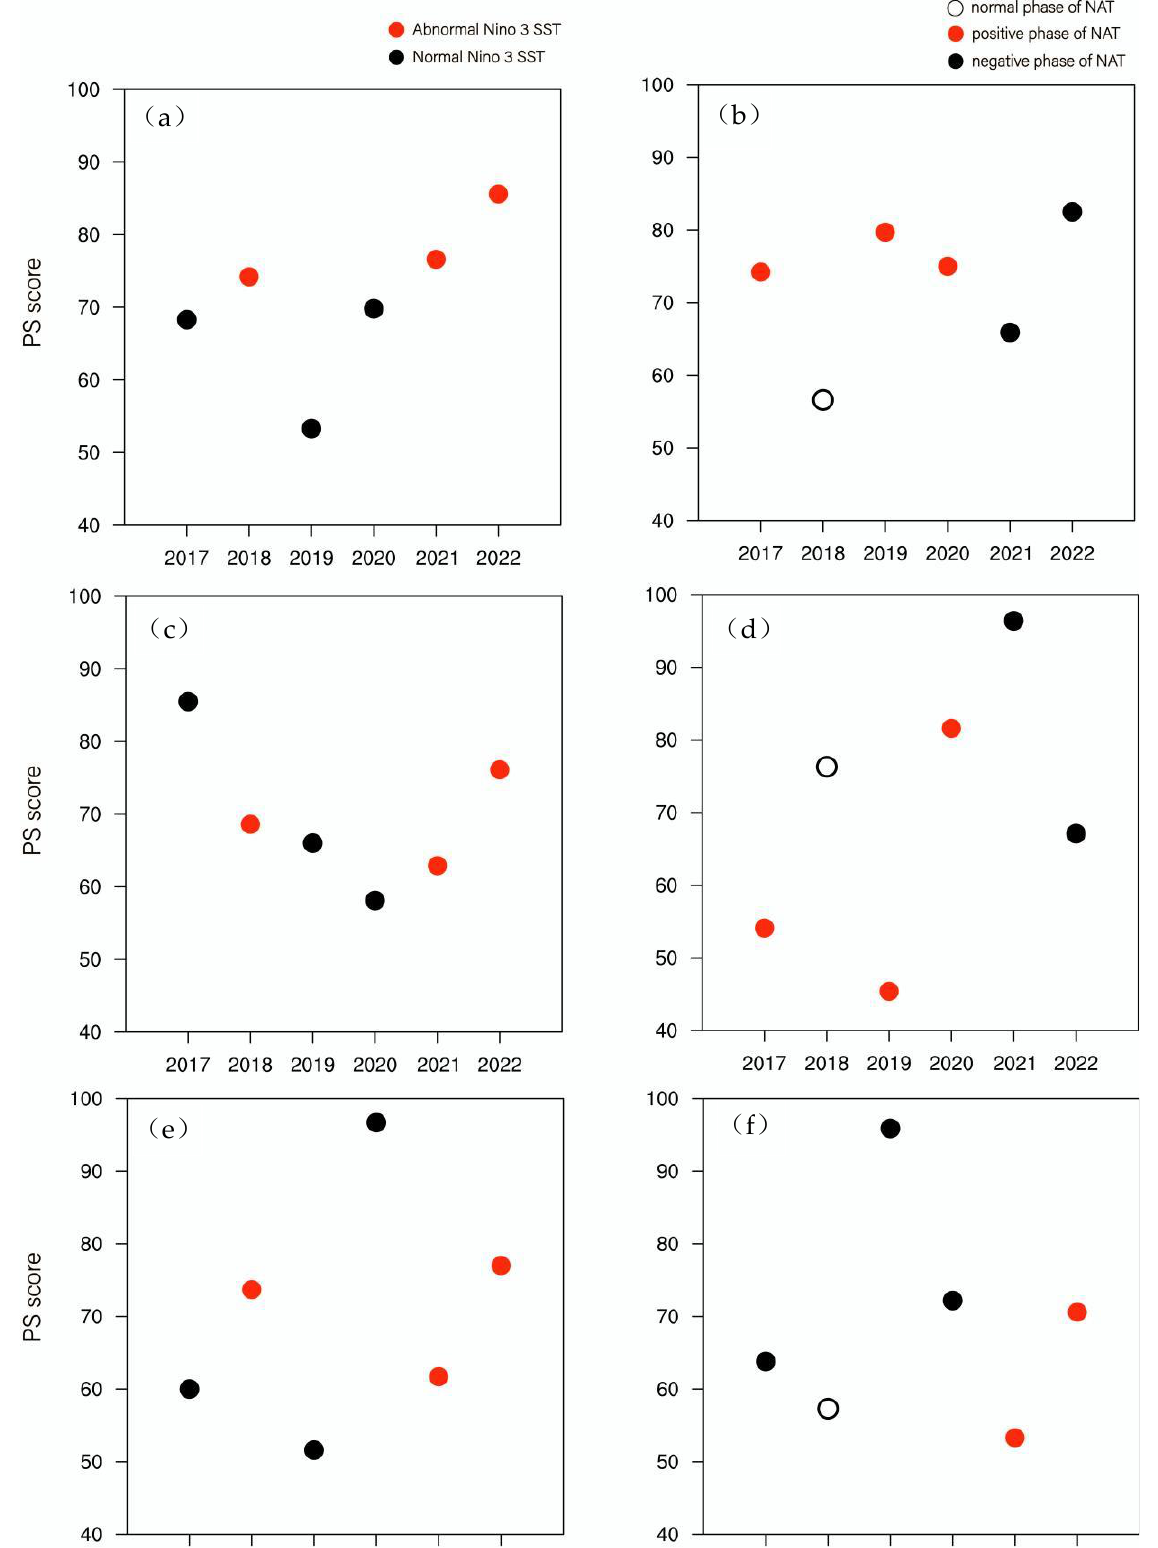
Figure 6. The PS scores of the precipitation prediction by the dynamic–analogue correction method (( a ): June; ( c ): July; ( e ): August) and the hybrid downscaling method (( b ): June; ( d ): July; ( f ): August).